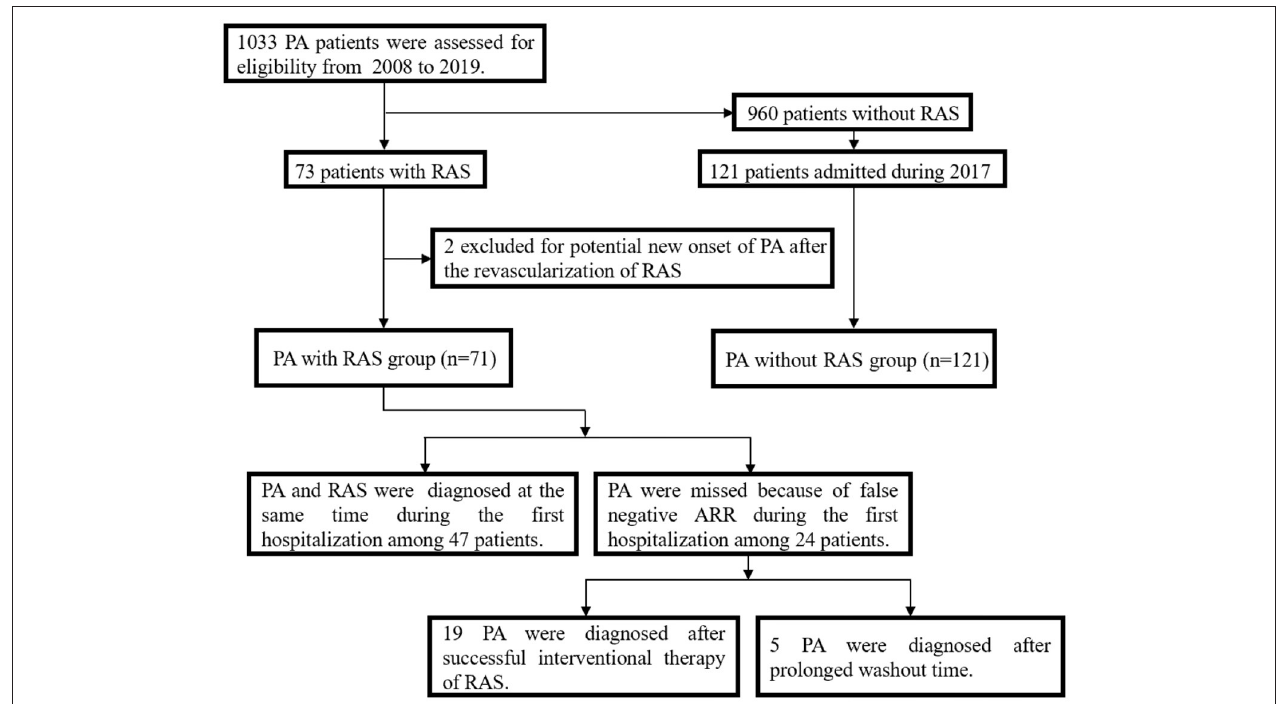
FIGURE 1 | Flow chart depicting the selection of the two groups, and the diagnostic process for patients in the primary aldosteronism (PA) with renal artery stenosis (RAS) group.